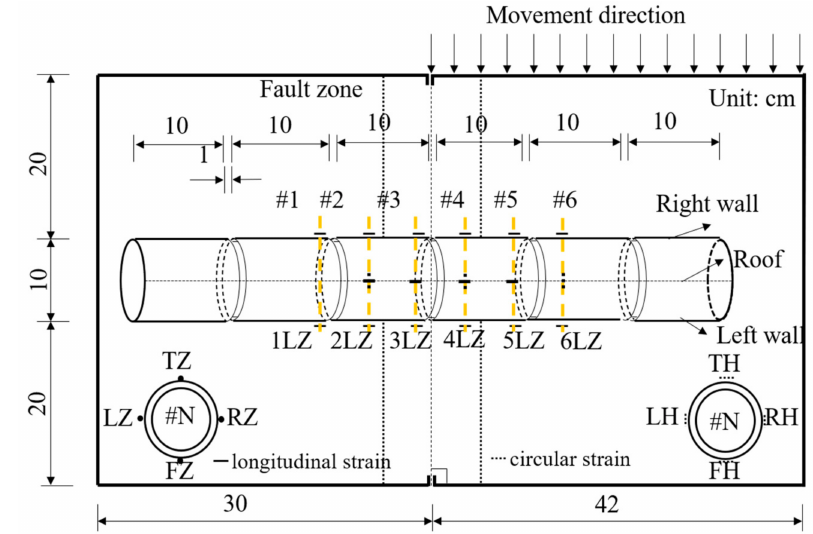
Figure 4. Strain gauges arrangement in a tunnel with flexible joints.